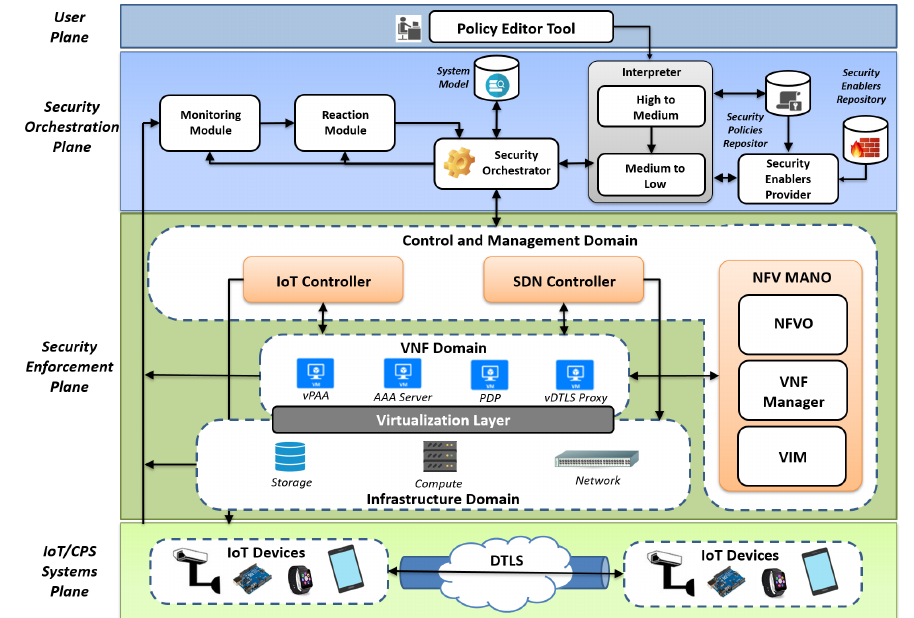
Figure 1. ANASTACIA Framework Architecture